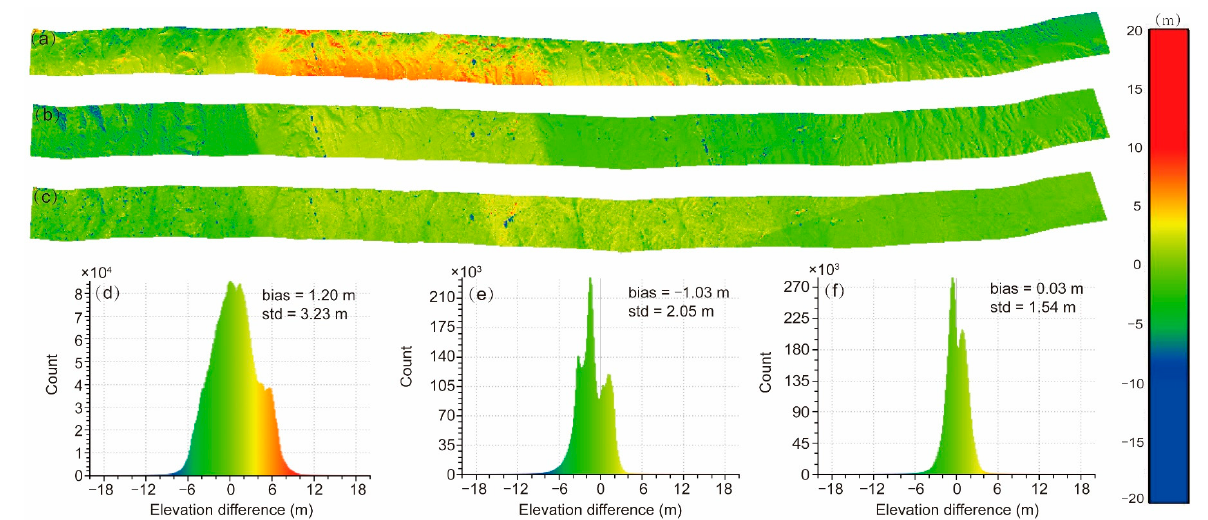
Figure 8. The spatial distribution and histogram of the difference in elevation between the GF-7 and airborne LiDAR point clouds: ( a , d ) GF-7 DEM Method1 ; ( b , e ) GF-7 DEM Method2 ; ( c , f ) for GF-7 DEM Method3. To explore the ability of GF-7 DEMs to reproduce the slope, the values of the terrain’s slope were calculated by the DEMs. Figure 9 shows the distribution of the slopes of the terrain calculated by the airborne LiDAR DEM and GF-7 DEMs. The results indicate that the slopes generated by the GF-7 DEMs agreed with those extracted from the airborne LiDAR data in most areas. The differences in the slope between the airborne LiDAR and GF-7 DEMs were also calculated, as shown in Figure 10. The results indicated that GF-7 DEM Method1 and GF-7 DEM Method3 were superior to GF-7 DEM Method2 for reproducing the slope of the terrain.